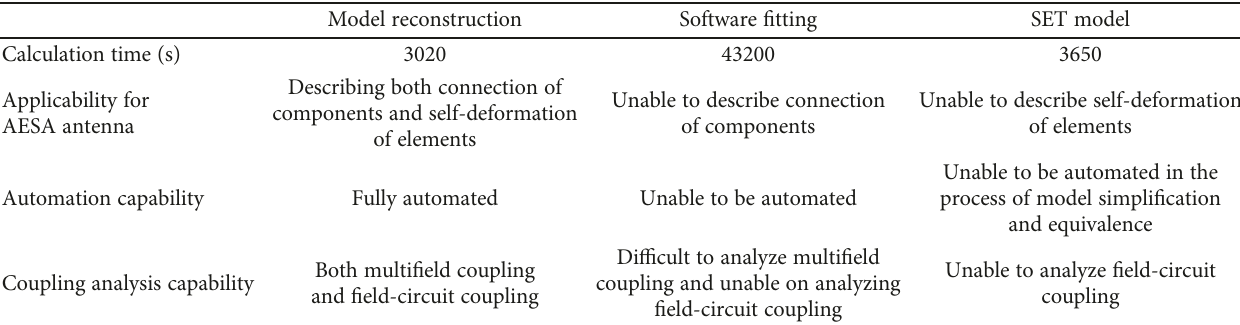
Table 4: Comparison of di ff erent methods in multi fi eld coupling